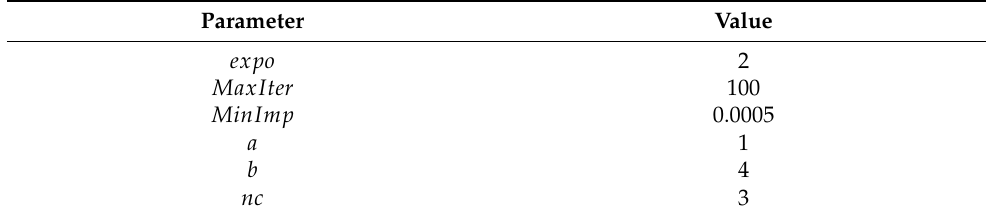
Table 3. Parameters of the PFCM